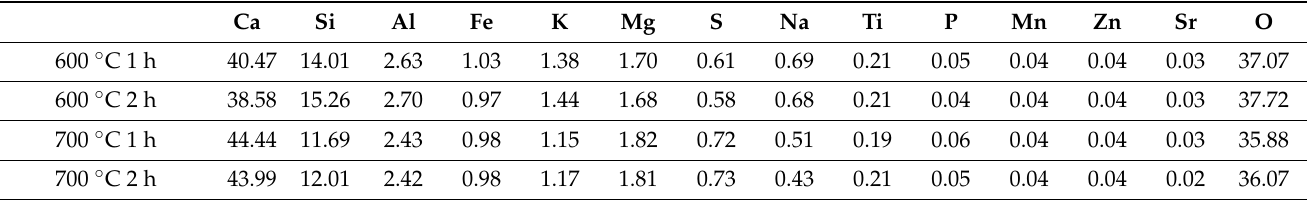
Table 3. Chemical compositions of recycled cement powder after heat treatment at 600 and 700 ◦ C for 1 and 2